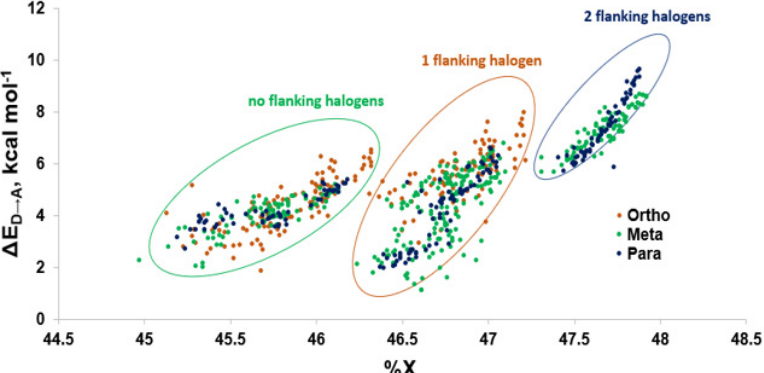
Figure 11. Comparison of donor-acceptor energies ( ∆ E D → A ) to percent contribution of X (%X) by XB position.